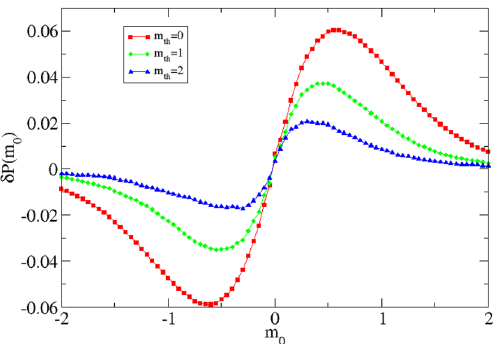
Figure 1. δ P as a function of m 0 for the southern California relocated catalog. Different symbols and colors indicate different m th